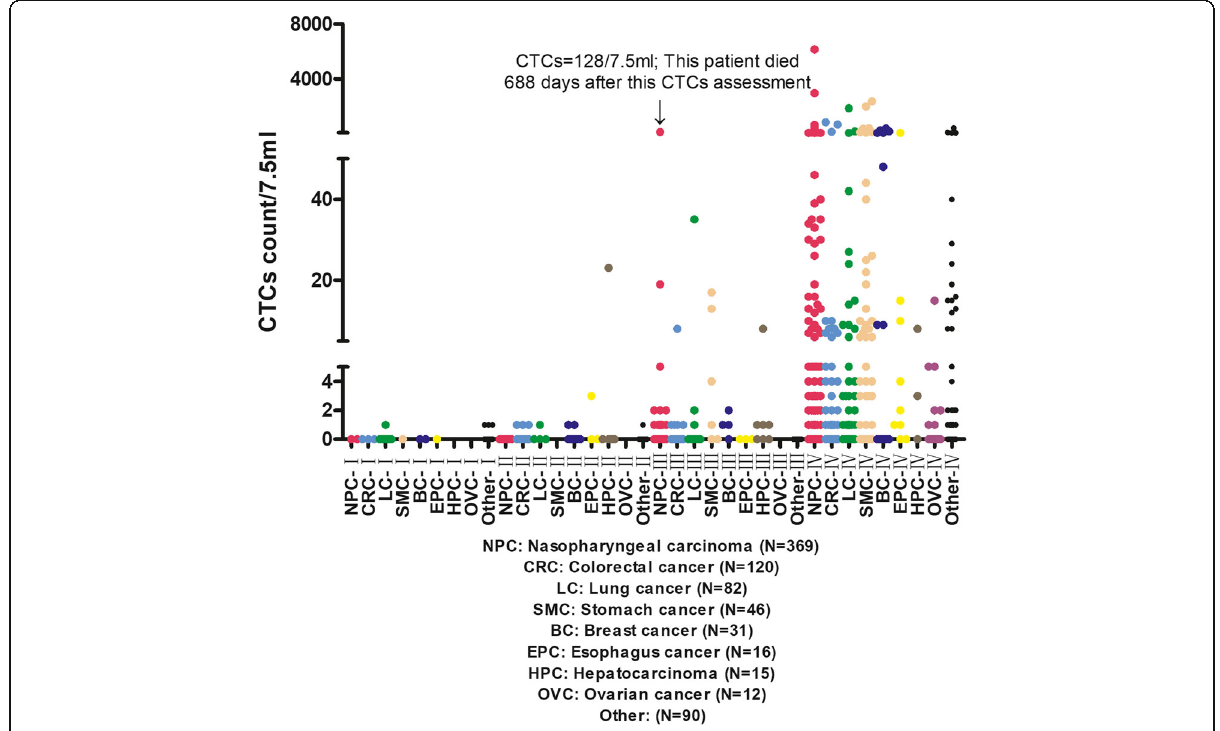
Fig. 1 Distribution of CTCs in different tumor types and clinical